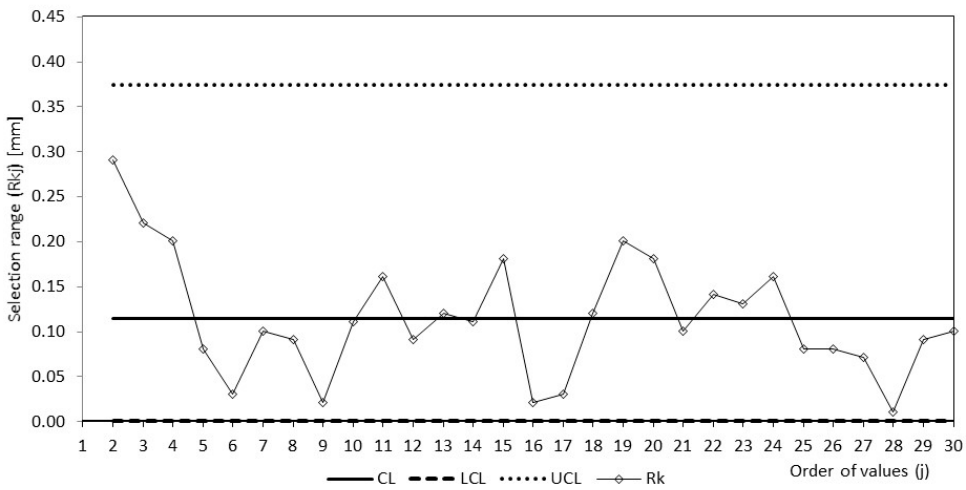
Figure 12. Shewhart control chart for sliding margins for the width parameter, third day. The second pair of constructed charts are charts (Figure 13) for individual values. Additionally, all values are found in the chart and so this process can be labelled, from the perspective of the calculated regulatory limits of Shewhart’s control charts, as stable. A maximum of half of the regulatory limits is reached, and points move regularly around the central